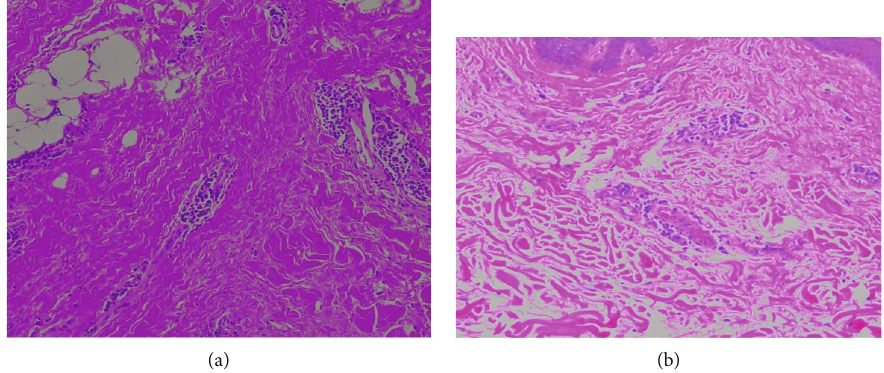
Figure 1: (a) Perivasculitis with edema of the dermis. (b) Perivasculitis with edema of the